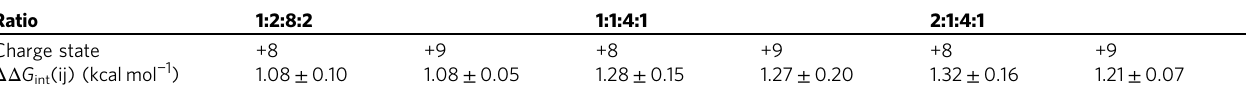
Table 4 Values of the coupling energy of Phe86 in E9 with Asp33 in Im2 Ratio